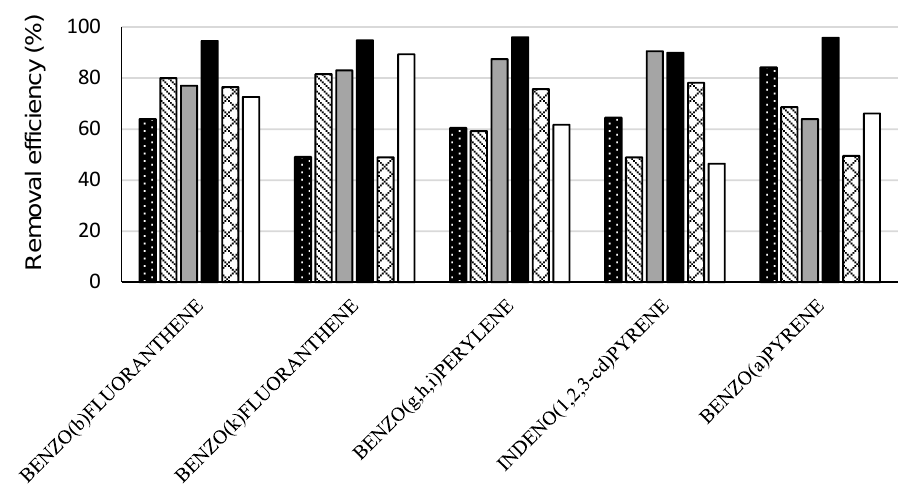
Figure 1. Removal efficiency of PAH standardized in the Council Directive 98/83/EC on the quality of water intended for human consumption.